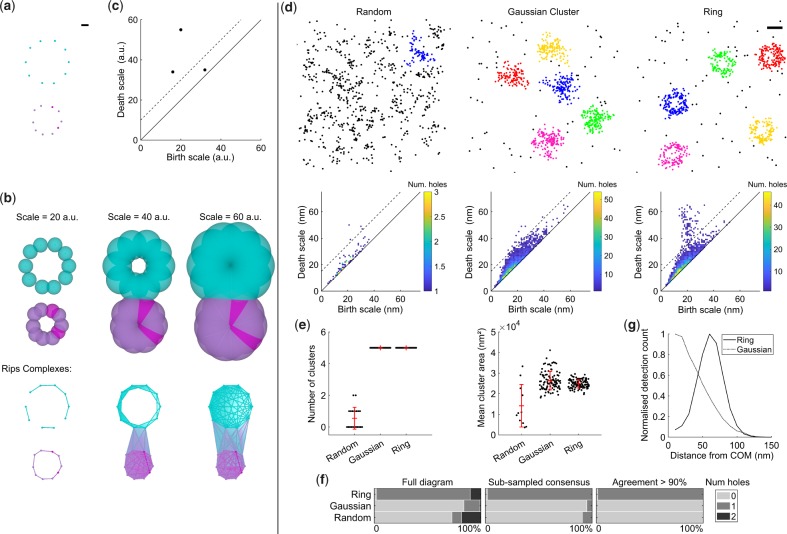
Persistent homology for topological analysis of clusters in SMLM datasets. (a) Illustrative example where detections are spaced evenly on the circumference of two circles. Scale-bar 10 arbitrary units (a.u.). (b) Building a filtration. Balls of varying diameter were placed at each detection (top) and the Rips complexes (bottom) were determined by the overlap of these balls. The filtration was evaluated for all integer values between 1 and 60 a.u. Without the filtration, it would be difficult to choose a scale which fully encapsulates the clustering and topology of the data. Simplex colour is set by the detection density estimate and is only for display purposes. (c) The persistence diagram summarizes structure within the filtration. The birth and death scales for each hole are shown. The persistence threshold is shown as a dotted line and there are two significant holes above this threshold. (d) Simulations for randomly distributed molecules, Gaussian clusters and rings with 60 nm radius were segmented using ToMATo. For each cluster a filtration was constructed and the corresponding persistence diagrams are shown. All holes have been grouped into a single persistence diagram per scenario. A persistence threshold of 15 nm was applied to all scenarios (dotted line). Scale-bar 100 nm. (e) Mean number of clusters and cluster area. Error bars are mean ± SD (f) Percentage of clusters with specified number of holes for each scenario. This was calculated using either the full diagram, the sub-sampled consensus, or the sub-sampled consensus with agreement > 90%. (g) Averaged radial distribution for clusters with agreement > 90%. As expected the peak of the profile for the ring simulation lies at 60 nm